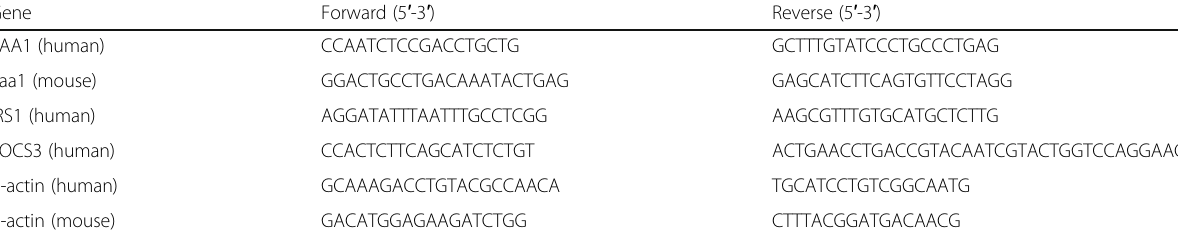
Table 1 Primer sequence for RT-qPCR Gene Forward (5 ′ -3 ′